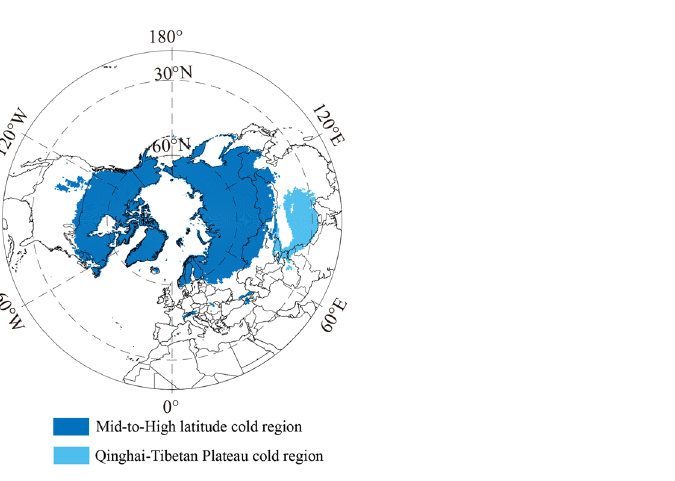
Figure 2. Spatial distribution of the cold regions in the NH from 1901 to